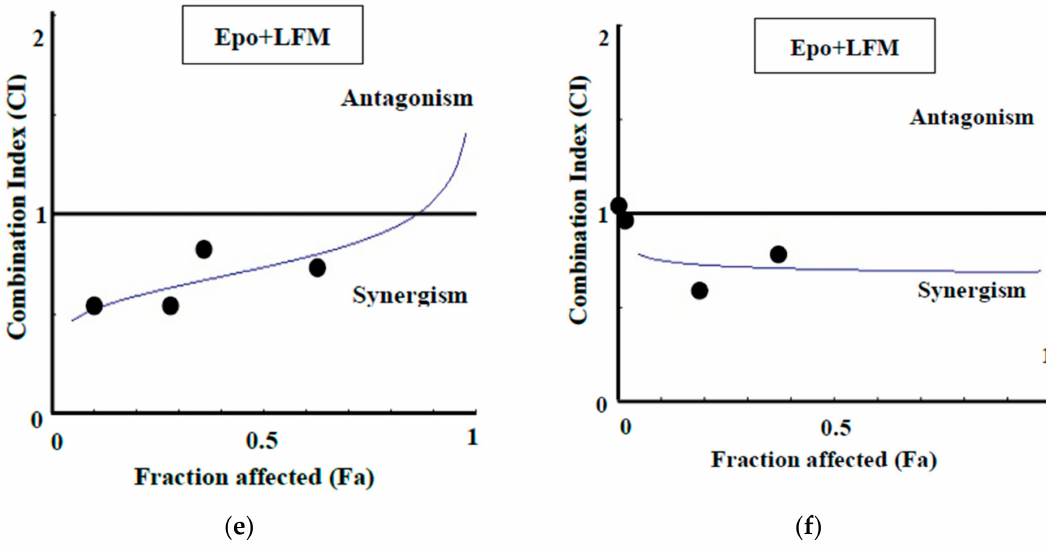
Figure 1. Effects of erythropoietin β (Epo), LFM-A13 (LFM), and their combinations on colon cancer cells. Impact of LFM-A13 (LFM) on cell viability of DLD-1 cells ( a ) and HT-29 cells ( b ); * p < 0.05, ** p < 0.01 (versus control (Con)). Effect of erythropoietin β (Epo), LFM-A13 (LFM), and their combined activity on cell viability of DLD-1 ( c ) and HT-29 ( d ) colon cancer cells; * p < 0.05 (vs. Con), *** p < 0.001 (vs. Con); ˆ p < 0.05 (vs. Epo), ˆˆˆ p < 0.001 (vs. Epo); # p < 0.05 (vs. LFM-A13), ## p < 0.01 (vs. LFM-A13), ### p < 0.001 (vs. LFM-A13). Combination index (CI) analysis of erythropoietin (10–100 IU/mL) combined with LFM-A13 (10–100 µ M) at a constant ratio in DLD-1 ( e ) and HT-29 ( f ) cells. Synergistic effects are defined as CI < 1, additive effects as CI = 1, and antagonistic effects as CI >